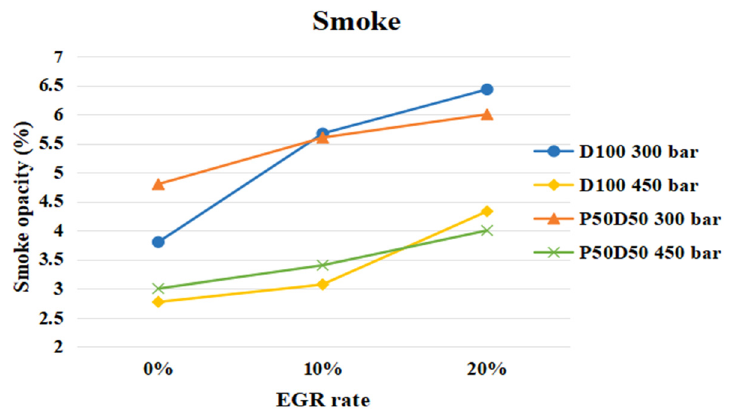
Figure 15. Smoke opacity under different EGR rates at 300 and 450 bar.